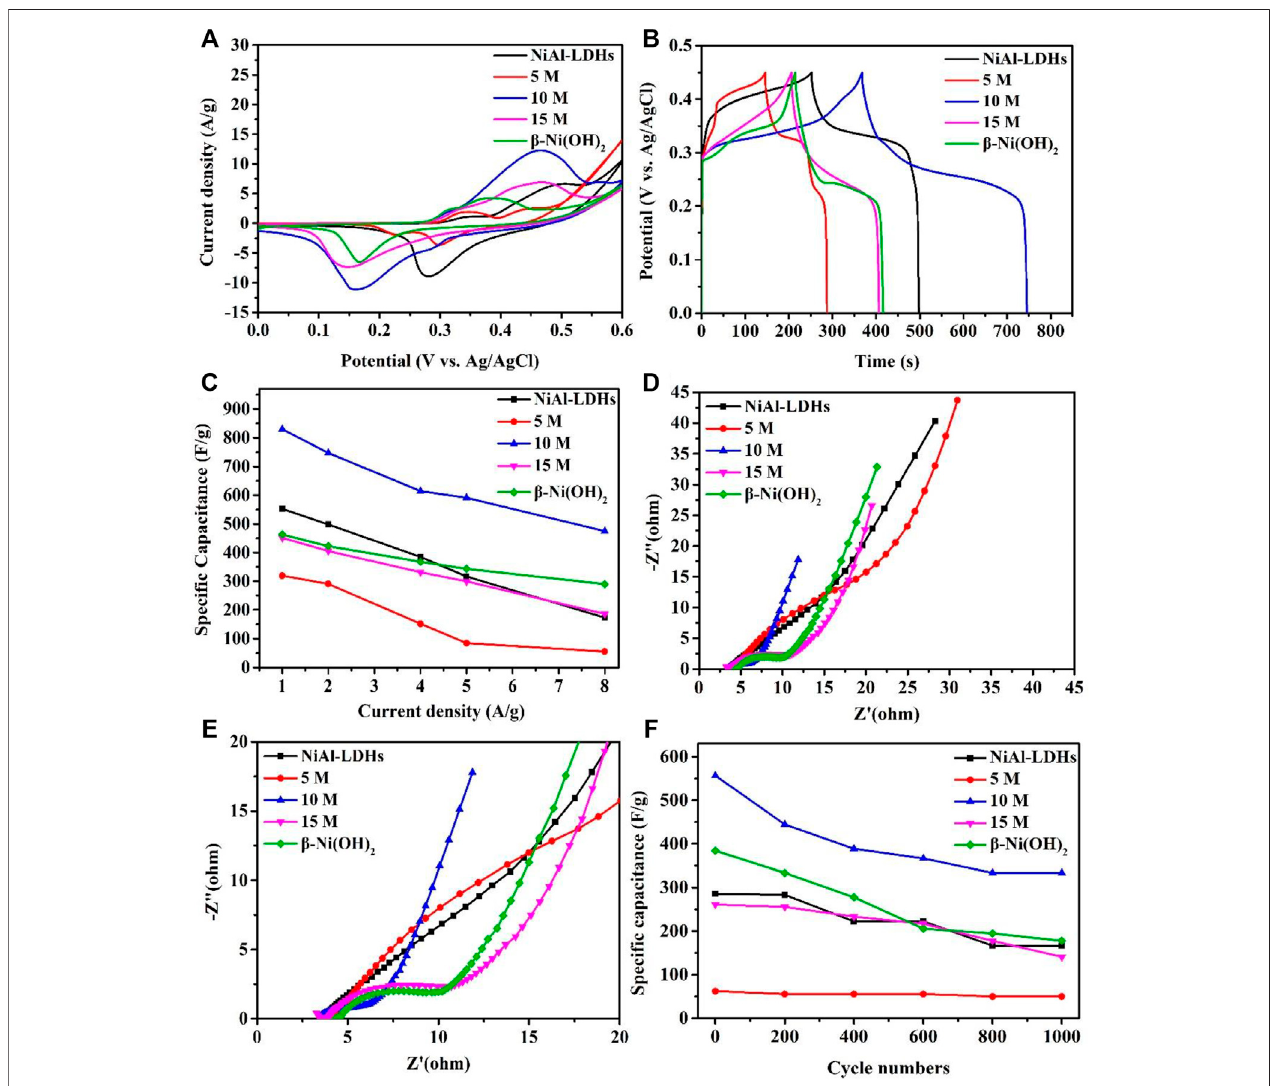
FIGURE 7 | Supercapacitive performance of NiAl-LDHs precursor, the alkaline-etched samples in 5, 10, and 15 M KOH solution, and β -Ni(OH) 2 sample prepared by precipitation reaction. (A) CVs curves at 5 mV/s; (B) GCD curves at 1 A/g within 0 – 0.45 V; (C) Speci fi c capacitance at different current density; (D) Nyquist plots of EIS, showing the imaginary part versus the real part of impedance; (E) a larger version of Nyquist plots of (d); (F) cycle performance measured at 5 A/g for 1,000 cycles.